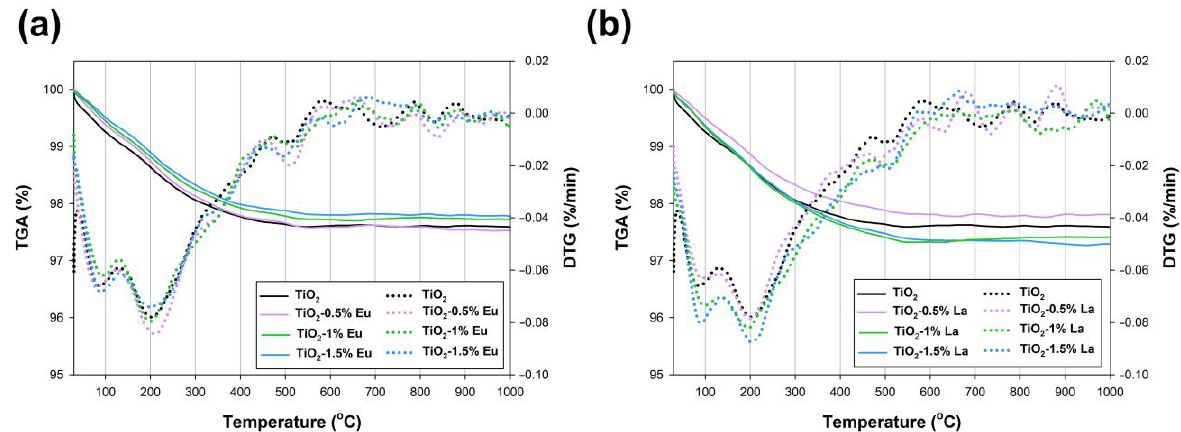
Figure 10. TGA/DTG results for TiO 2 -Eu ( a ) and TiO 2 -La ( b ) samples.